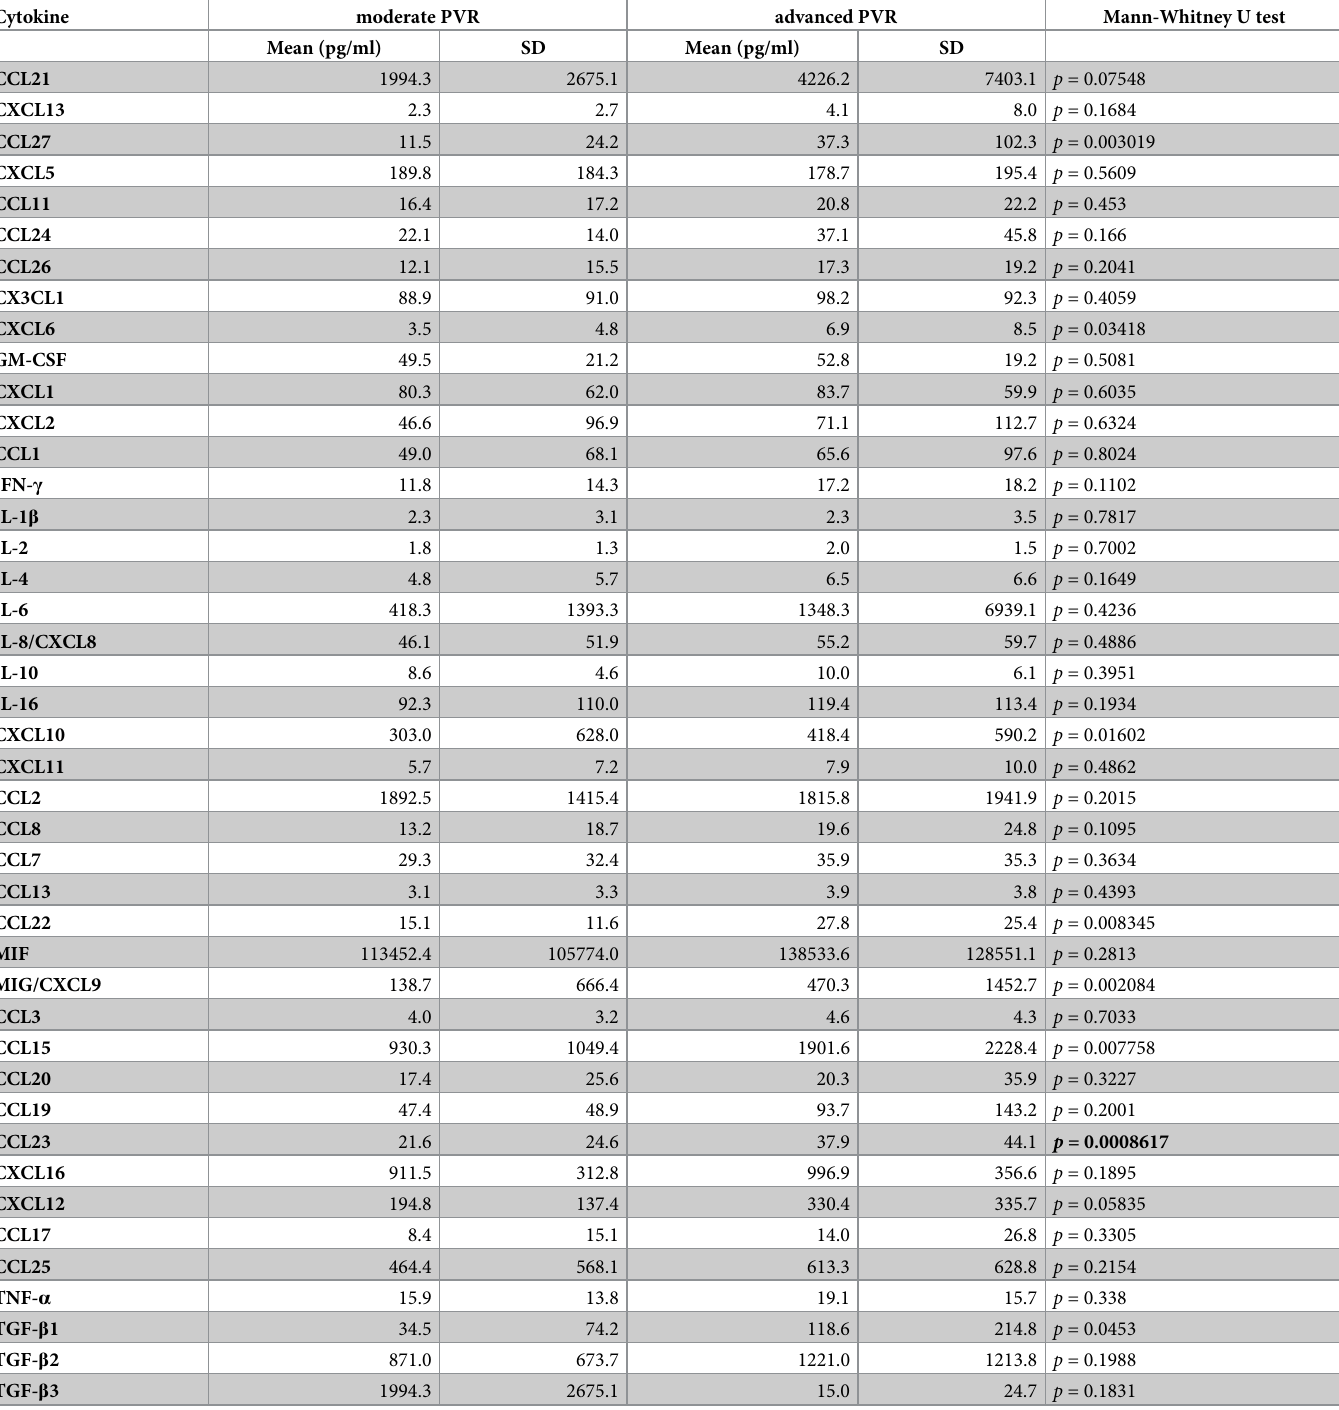
Table 3. Mean concentrations (pg/ml) and standard deviations (SD) of cytokines in the vitreous of eyes with primary retinal detachment with moderate PVR treated with